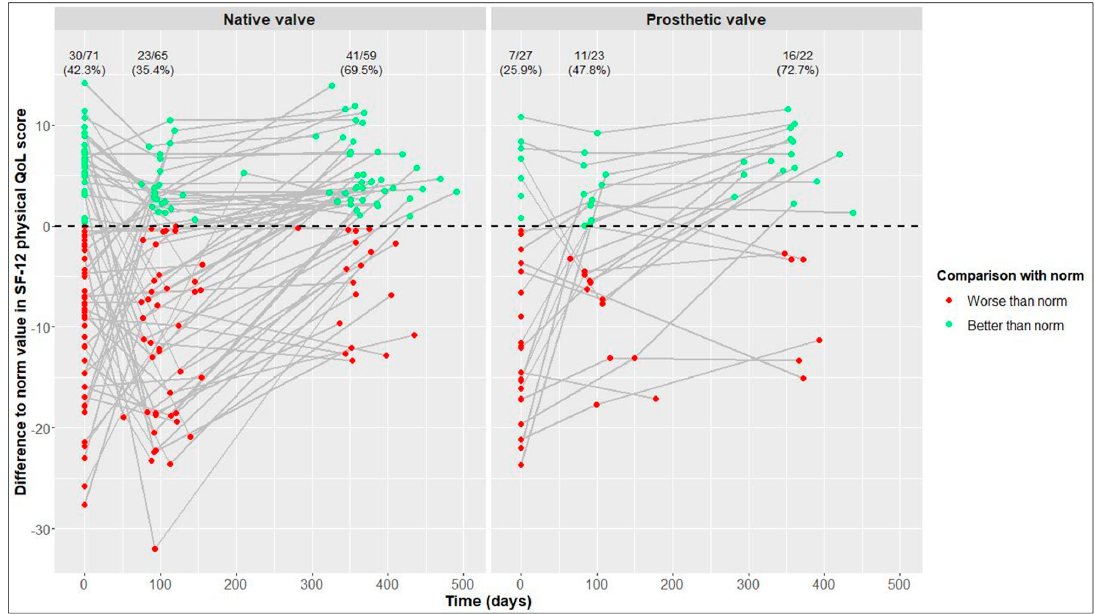
Figure 5. Differences between our values and reference values of 12-Item Short Form Health Survey (SF-12) physical quality of life (QoL) [21] in native valve vs. prosthetic valve patients; measurements of individual patients are represented by separate dots and connected to show time trend; absolute and relative frequencies of patients reaching reference values are displayed (raw data).